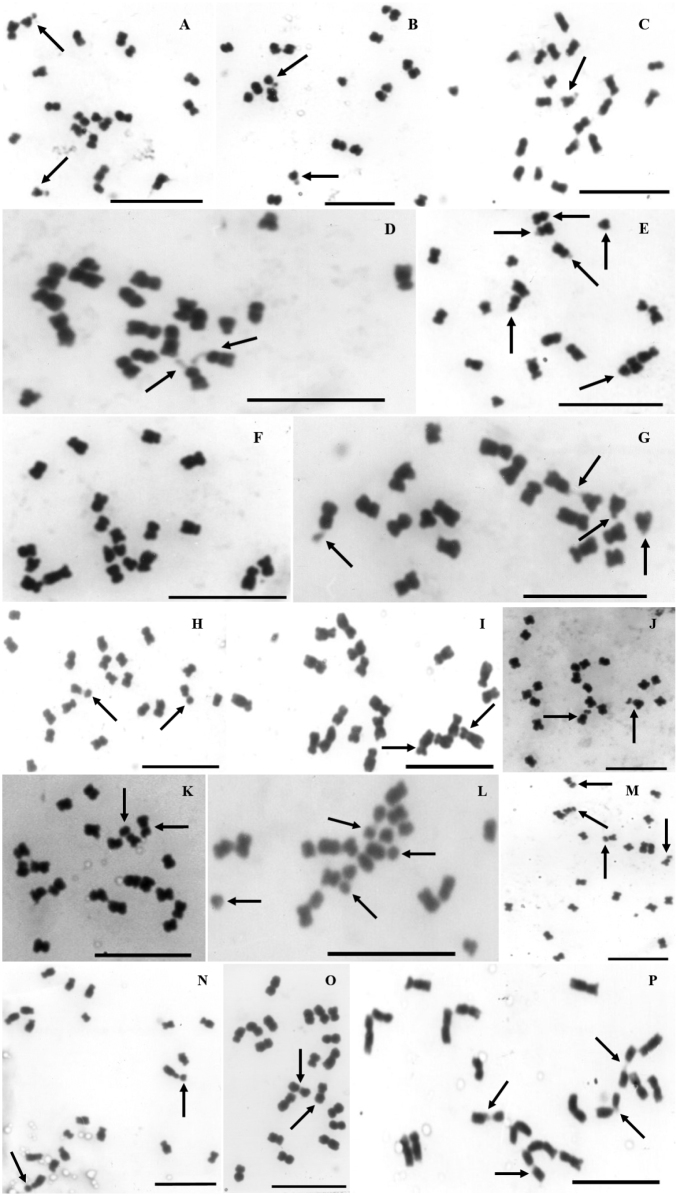
Mitotic metaphase cells of Aeschynomene, all the taxa with 2n = 20. Subgenus
AeschynomeneA–G series Americanae AA.
americanaBA.
americana
var.
flabellataCA.
americana
var.
glandulosaDAeschynomene
sp.
prope
americanaEA.
villosa
var.
villosaFA.
villosa
var.
longifoliaGAeschynomene
sp.
prope
villosaH, I series Sensitivae HA.
sensitivaIA.
deamiiJ–M series Indicae JA.
scabraKA.
eveniaLA.
rudisMA.
ciliataSubgenus
OchopodiumN–P series Pleuronerviae NA.
paniculataO, P series Scopariae OA.
lyonnetiiPA.
amorphoides. The arrows point to the chromosomes with satellites. Scale bars: 10 μm.